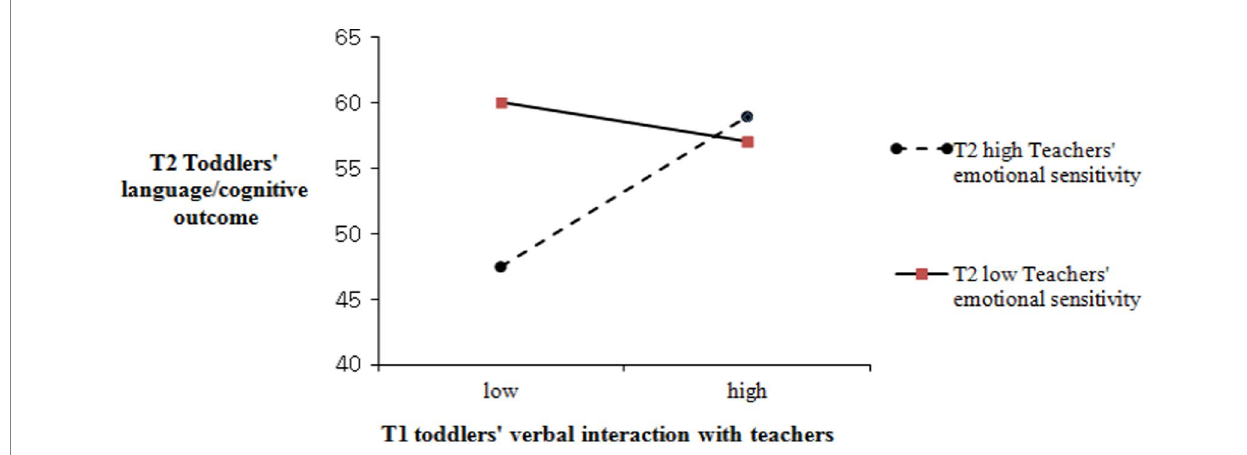
FIGURE 1 Two-way interaction for T1 toddlers’ verbal interaction with teachers and T2 high teachers’ emotional sensitivity predicting language/cognitive development at